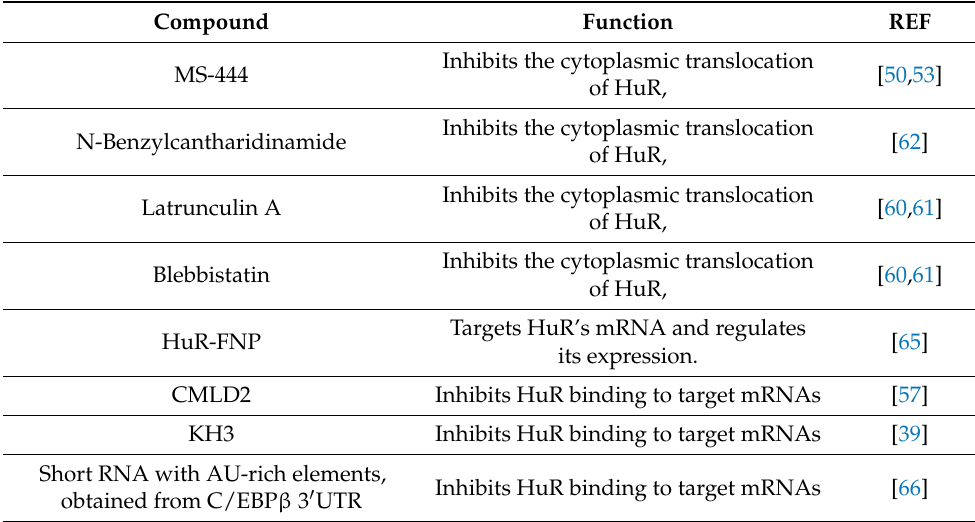
Table 2. The different functions of the compounds targeting